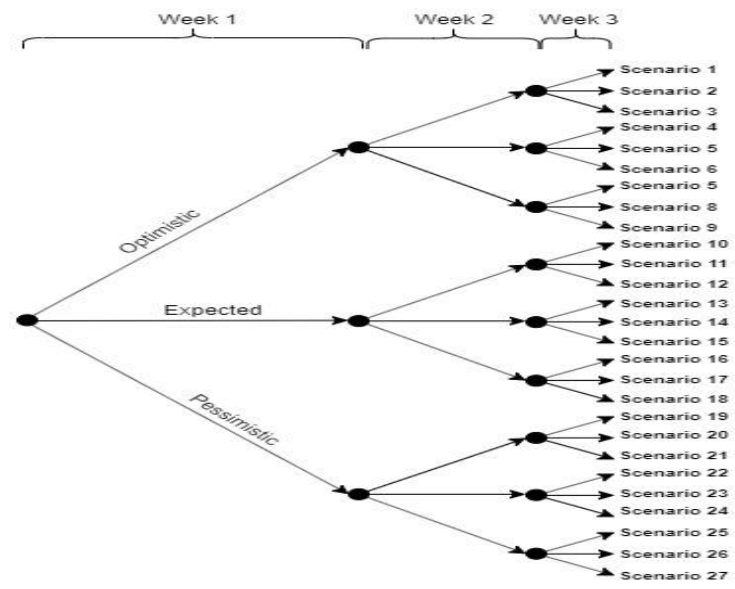
Figure 1. Scenario Figure 1. Scenario tree.